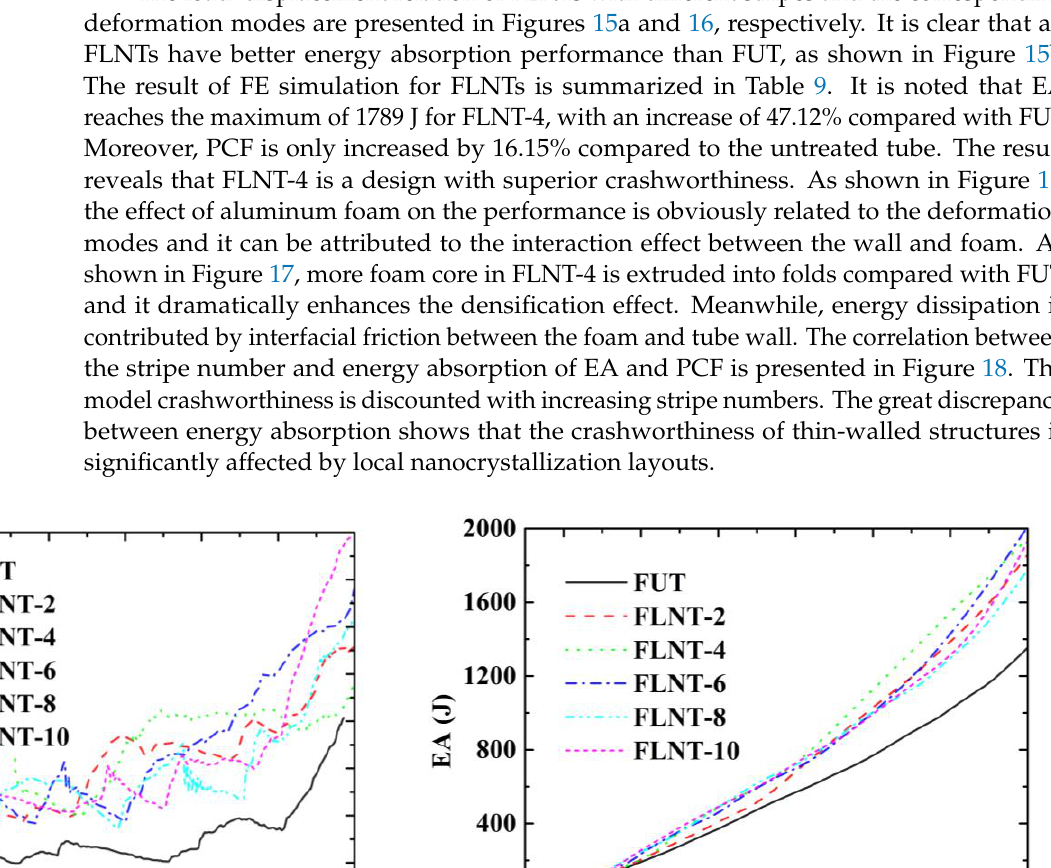
Figure 16. Deformation modes: ( a ) untreated; ( b ) FLNT-2; ( c ) FLNT-4; ( d ) FLNT-6; ( e ) FLNT-8; and ( f ) FLNT-10. Table 9. Crashworthiness data for different stripe number filled tubes. Model